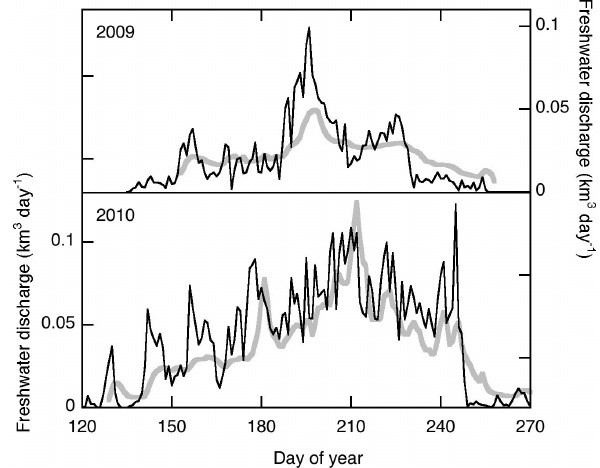
Fig. 8. Calculated daily totals of surface meltwater runoff for the Kangerlussuaq catchment (black) and the freshwater flux estimated from river depth measurements (grey) for 2009 and